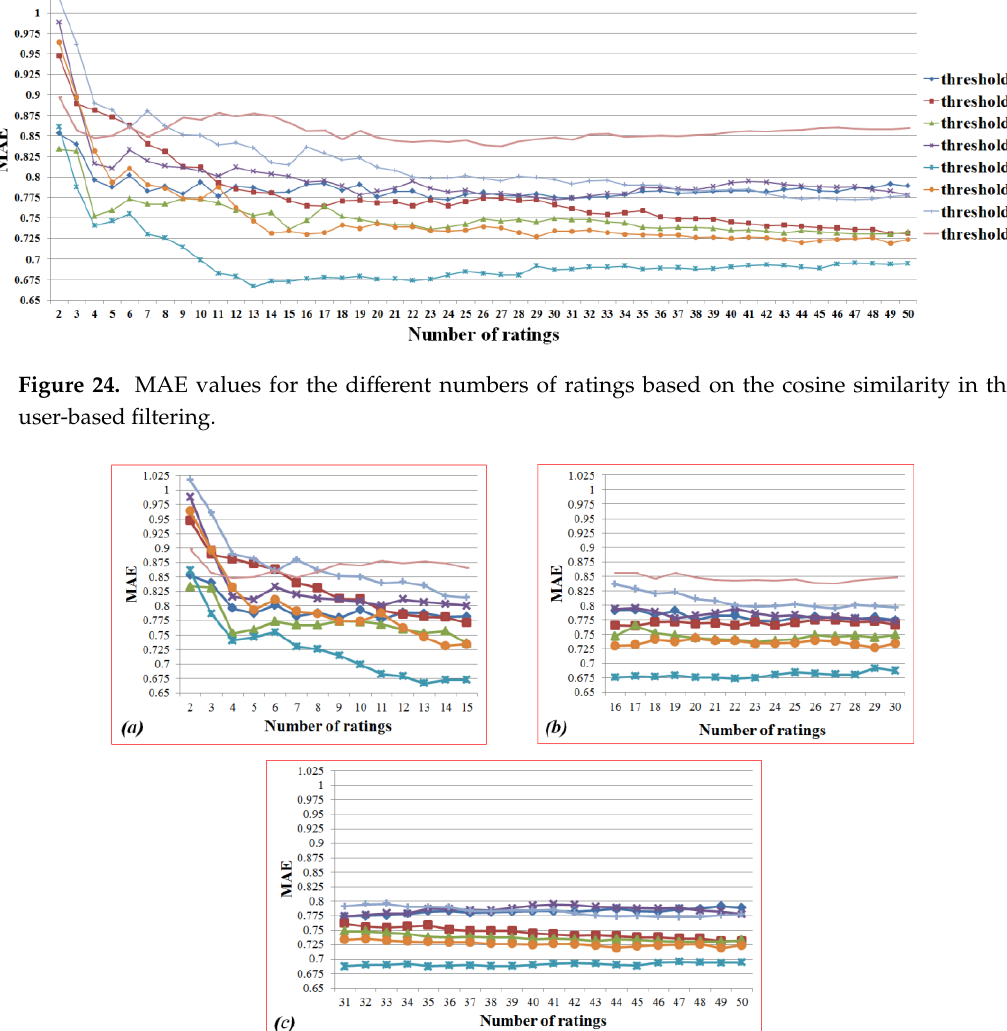
Figure 25. Sub-graphs of Figure 24: ( a ) the ranges from 2 to 15; ( b ) from 16 to 30; ( c ) from 31 to